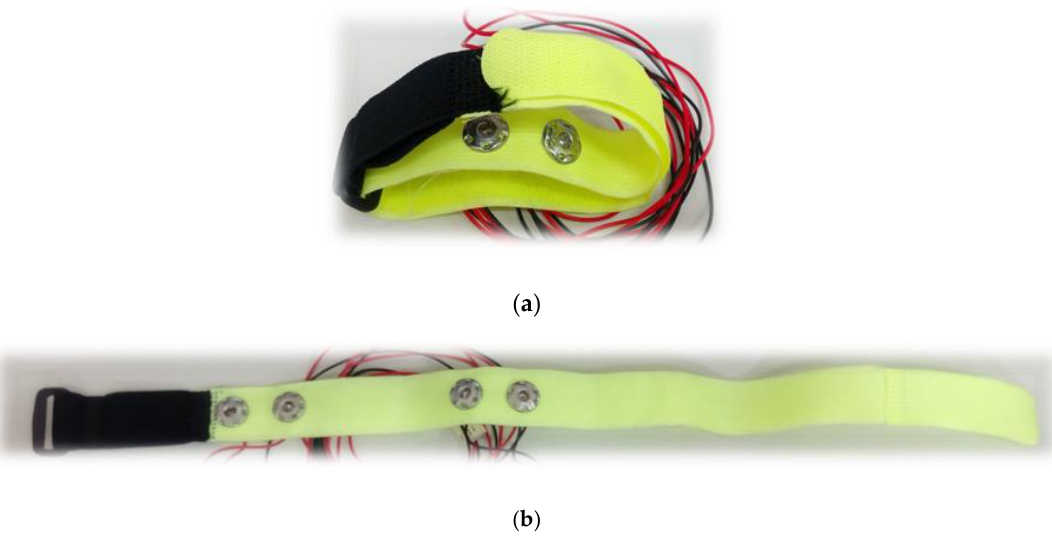
Figure 7. The real photo of the IPG ring with a width of 3 cm, and the bipolar electrode was in a symmetrical placement for the transmitting electrodes and receiving electrodes, ( a ) The IPG ring; ( b ) The extension of the IPG ring. Table 1. There were twelve placements for the electrode array according to Figure 3.